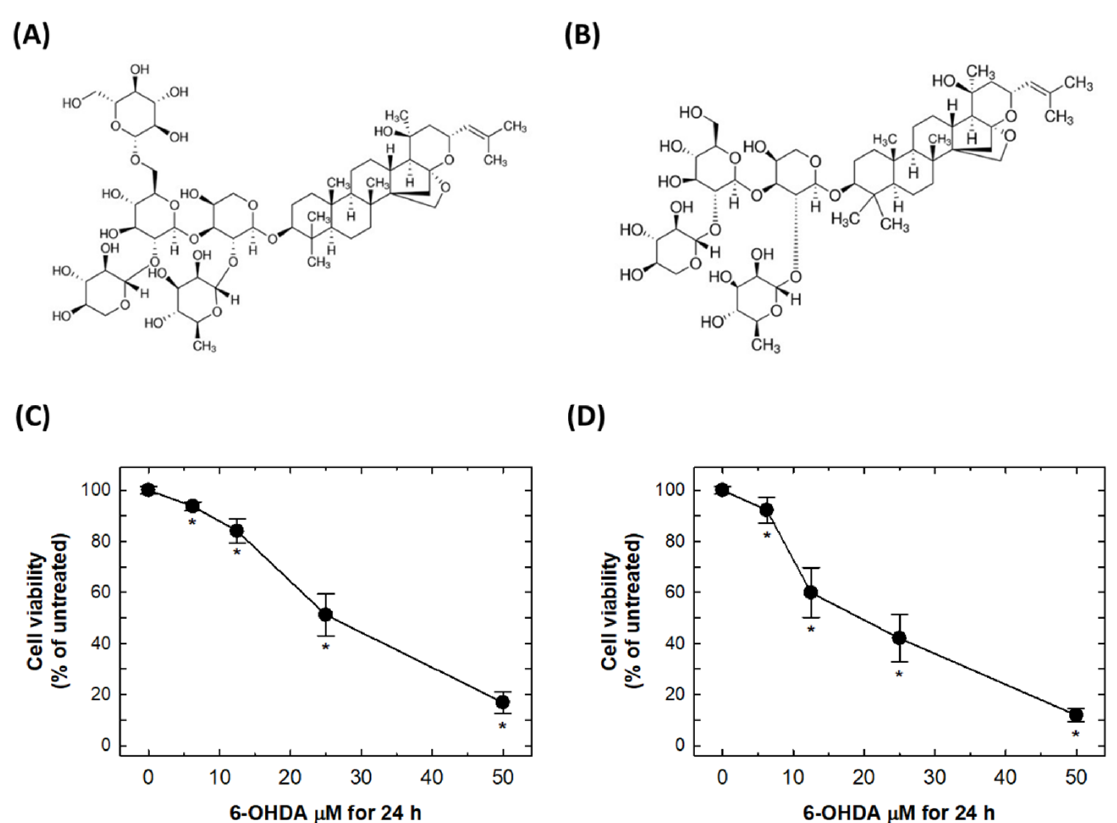
Figure 1. Structures of jujuboside A and B, and 6-OHDA suppressive effects on cell viabilities in SH-SY5Y, and SK-N-SH cells. ( A , B ) Structures of jujuboside A and B, respectively. ( C , D ) 6-OHDA suppressive effects on cell viabilities in SH-SY5Y and SK-N-SH cells, respectively. * Statistically significant from untreated group. Each experiment was repeated for at least 6 times.